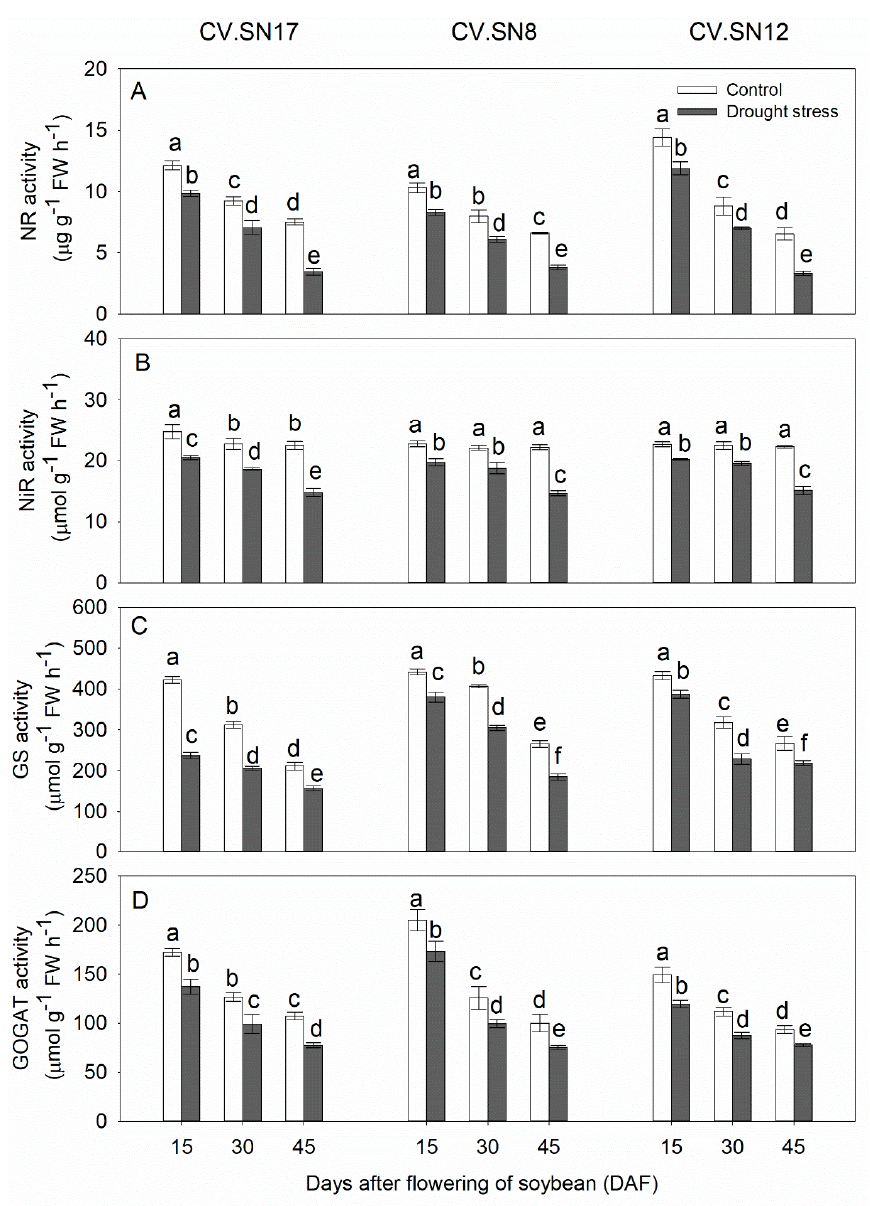
Figure 3. Changes of ( A ) NR activities, ( B ) NiR activities, ( C ) GS activities, and ( D ) GAGAT activities in leaves of CV.SN17, CV.SN8, and CV.SN12 under control and drought stress conditions. Data show the means ± standard deviation of three independent samples. Different letters above vertical bars indicate significant differences between means at a p < 0.05 level.